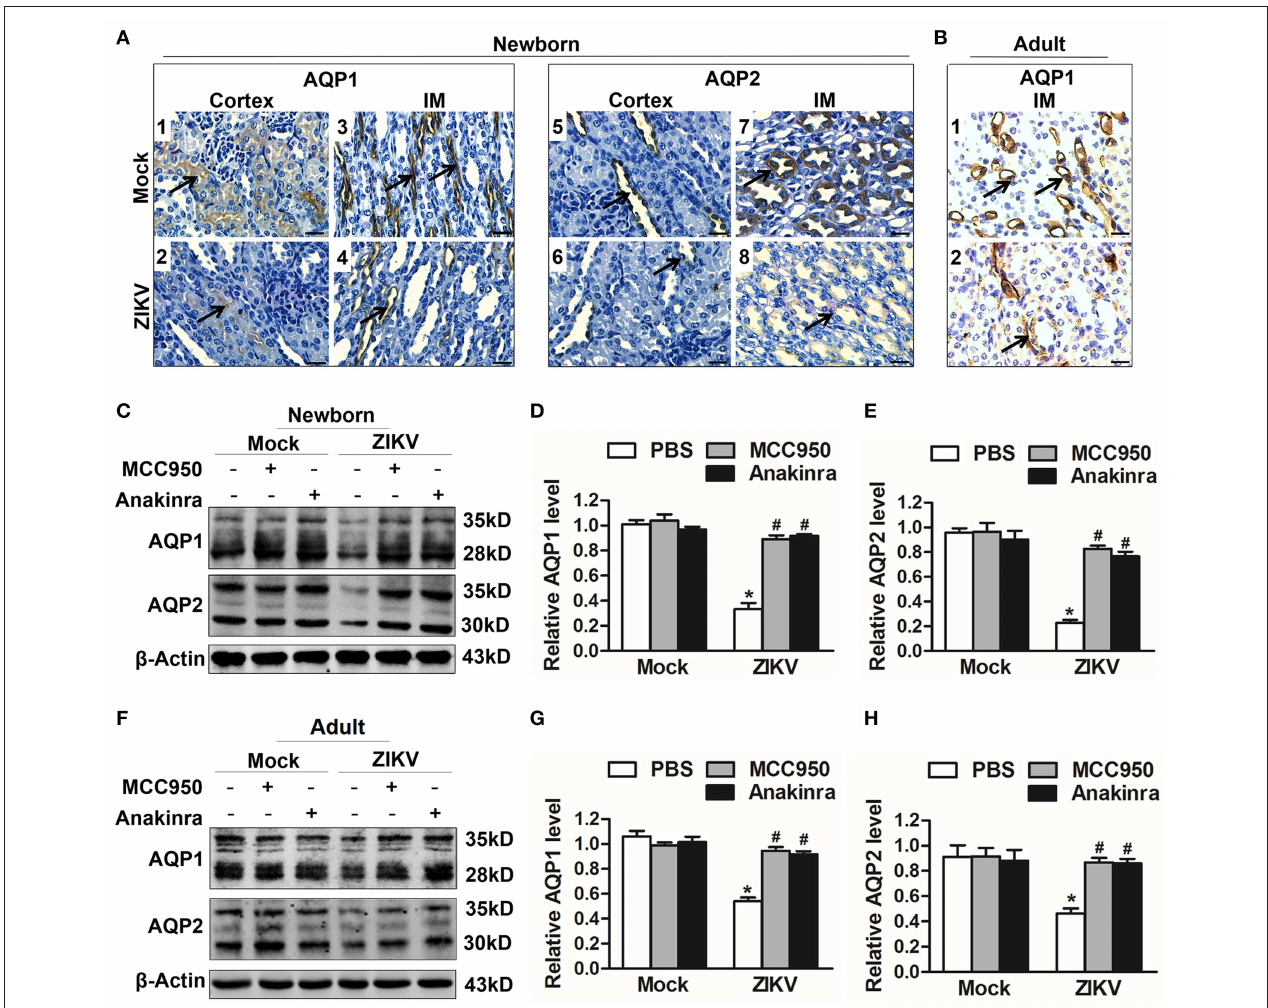
FIGURE 6 | ZIKV-induced IL-1 β decreased the expression of aquaporins in renal cells. (A,B) Immunohistochemistry analysis of kidney sections showed comparable low immunoreactivity in the AQP1 and AQP2 labeling in both cortex and inner medulla (IM) of kidneys in newborn mice (A) and adult mice (B) at 7 days post-infection. The black arrows depicted AQP1and AQP2 expression. Scale bars, 40 µ m. (C–H) The expression of AQP1 and AQP2 in the kidneys of newborn mice (C–E) and adult mice (F–H) were assessed by western blot at 7 days post-infection. The statistical graphs were shown as the mean ± SEM; N = 6 mice/group, * p < 0.05 vs. mock group; # p < 0.05 vs. ZIKV